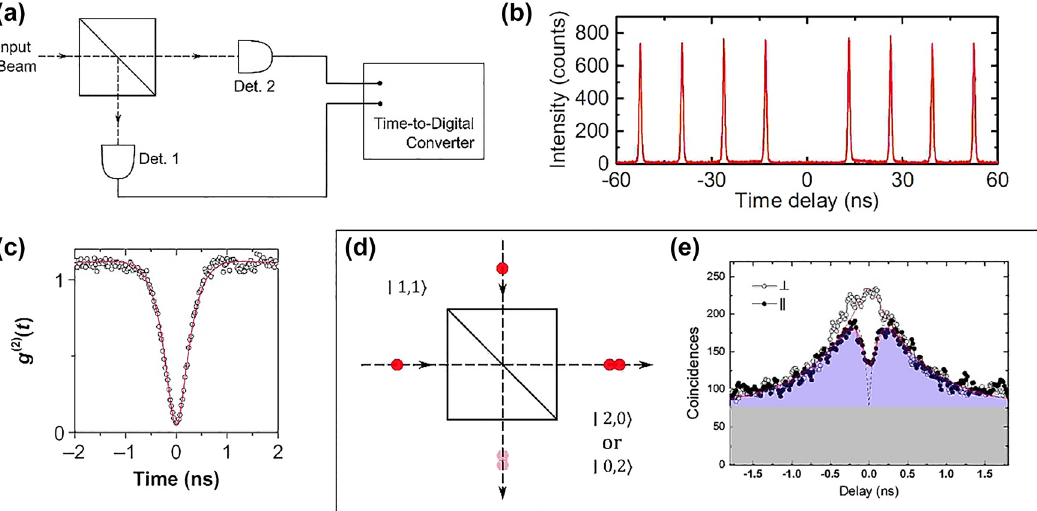
Figure 5: Hanbury Brown and Twiss (HBT) measurement of the second-order correlation function and Hong-Ou-Mandel (HOM) interference. (a) Schematic of a basic HBT setup. The time-to-digital converter records photon detection times and the normalized histogram of time differences t between detectors 1 and 2 is the g (2) ( t ) function for the input beam. (b) g (2) ( t ) function (unnormalized) for emission from quantum dotspumpedbyapulsedlaser,ratherthanshowingananti-bunchingdip,thepeakat t =0ismissing.AdaptedfromthestudybyBennettetal. [121] under Creative Commons Attribution 4.0 International License. (c) Normalized g (2) ( t ) function for anti-bunched emission from a quantum dotpumpedbyacontinuouswavelaser.AdaptedfromthestudybyHanschkeetal.[122]underCreativeCommonsAttribution4.0International License. (d) Schematic of the HOM effect: a pair of indistinguishable photons arriving simultaneously at a beamsplitter can only produce photon pairs at the outputs. Therefore, no coincidences would be measured by detectors at each of the output ports for completely indistinguishableinputphotons.(e)HOMinterferencedip.Coincidencedetectionswhenpairsofsinglephotonpulsesfromaphotoniccrystal quantum dot are interfered on a beamsplitter, with parallel ∥ or perpendicular ⊥ polarizations. Parallel-polarized photons are indistinguishable and so coincidences at zero time delay are suppressed by the HOM effect. Adapted from the study by Kim et al. [123].